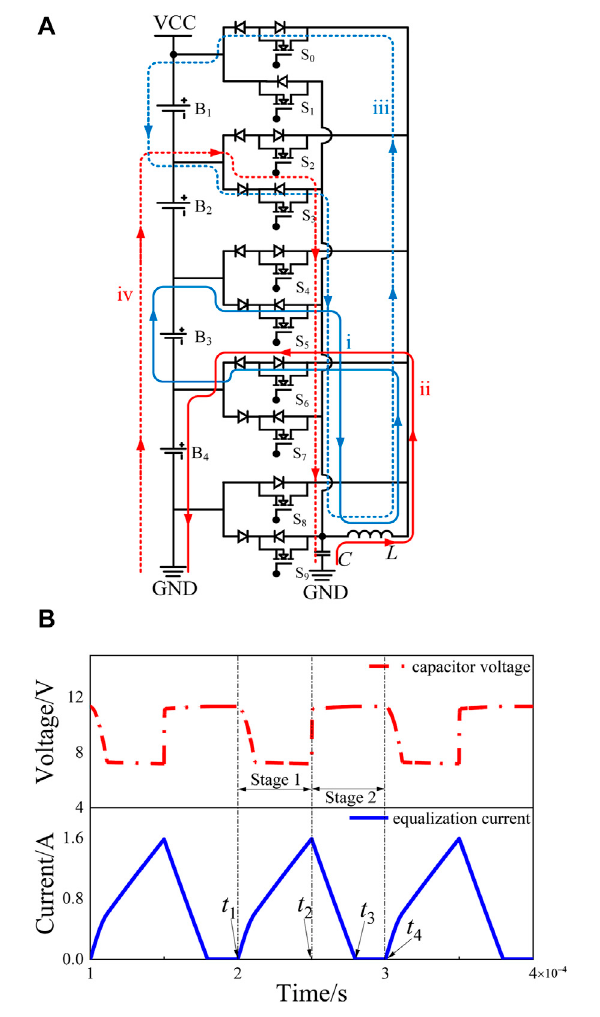
FIGURE 2 | The working principle of the power of B 1 is the highest and the B 3 is the lowest. (A) Balancing current loops. (B) Waveforms of the balancing current and capacitor voltage.